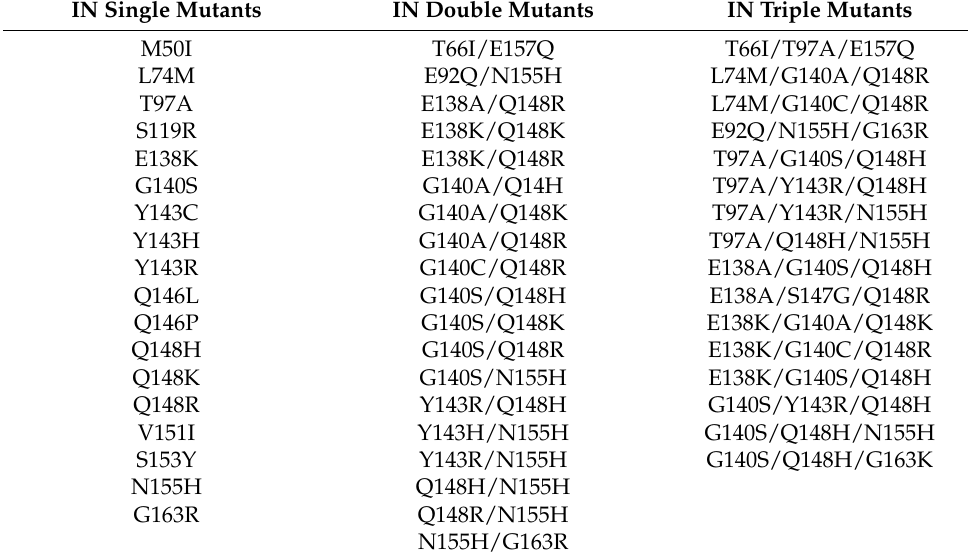
Table 1. Identification of raltegravir (RAL)-resistant mutants. IN single, double, and triple mutants that have been selected against RAL in patients, in vitro selection studies, or IN susceptibility assays are listed. IN Single Mutants IN Double Mutants IN Triple Mutants M50I T66I/E157Q T66I/T97A/E157Q L74M E92Q/N155H L74M/G140A/Q148R T97A E138A/Q148R